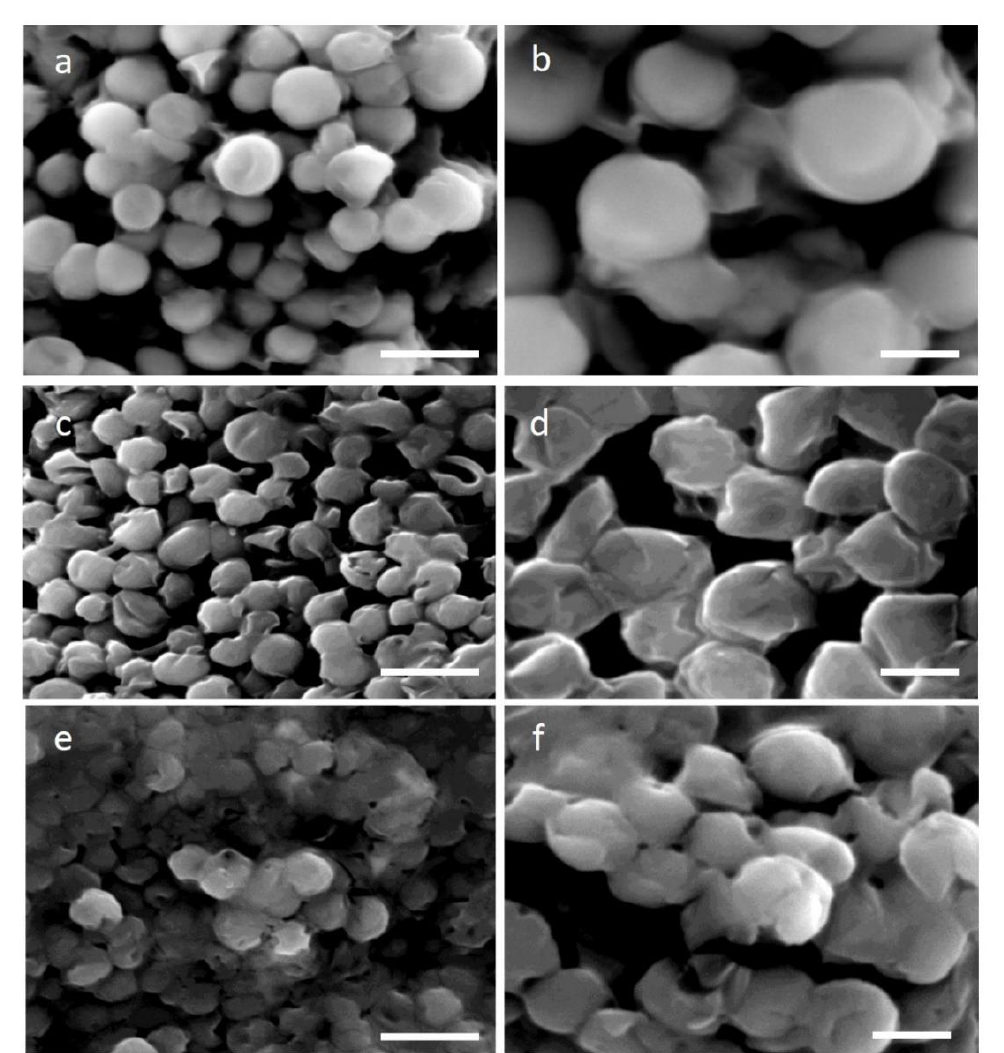
Figure 5. Recovery of H. pluvialis after the 8-h enzymatic digestion and the glass bead treatment as well as their transformation with magnetic particles. ( a , b ), two di ff erent magnifications of H. pluvialis control cells. ( c , d ), two di ff erent magnifications of H. pluvialis cells digested with cellulase and after 4 days of recovery. ( e , f ), two di ff erent magnifications of H. pluvialis cells pretreated with glass beads and after 4 days of recovery. Scale bar on the left column is 5 µm whereas in the right column, it is 2 µm.